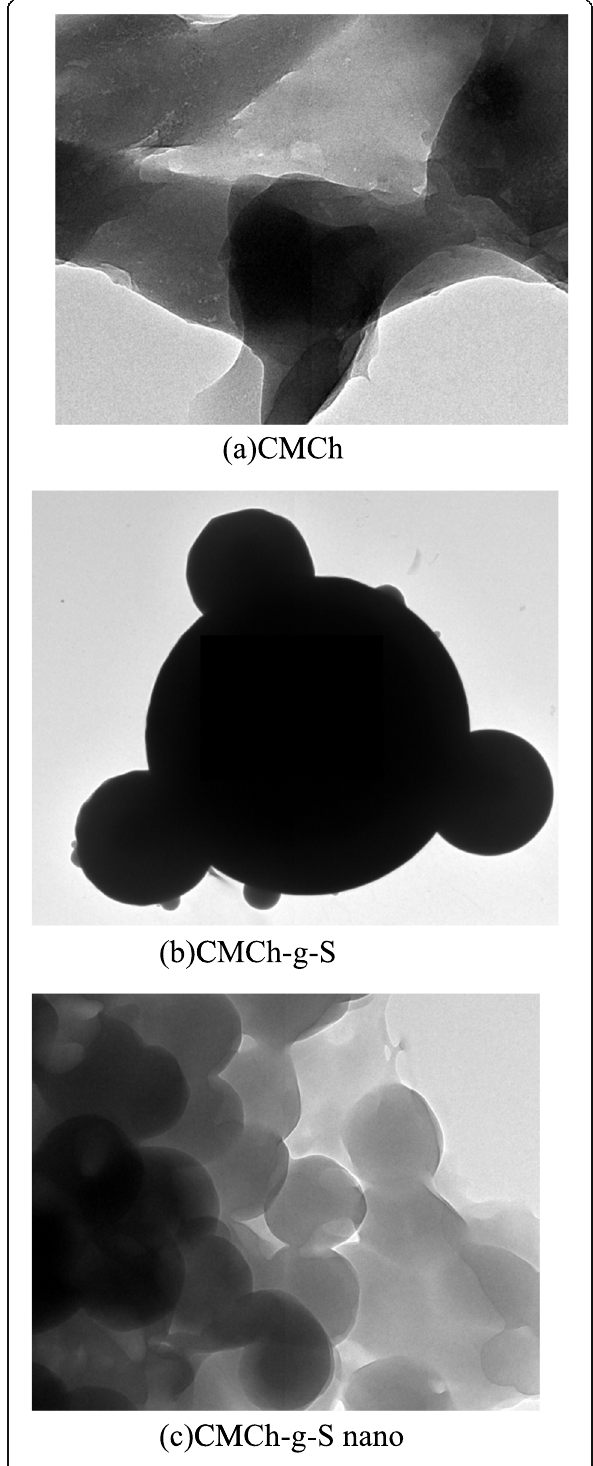
Fig. 8 TEM photography of ( a ) CMCh, ( b ) CMCh-g-S and ( c ) CMCh- g-S nano at optimum grafting